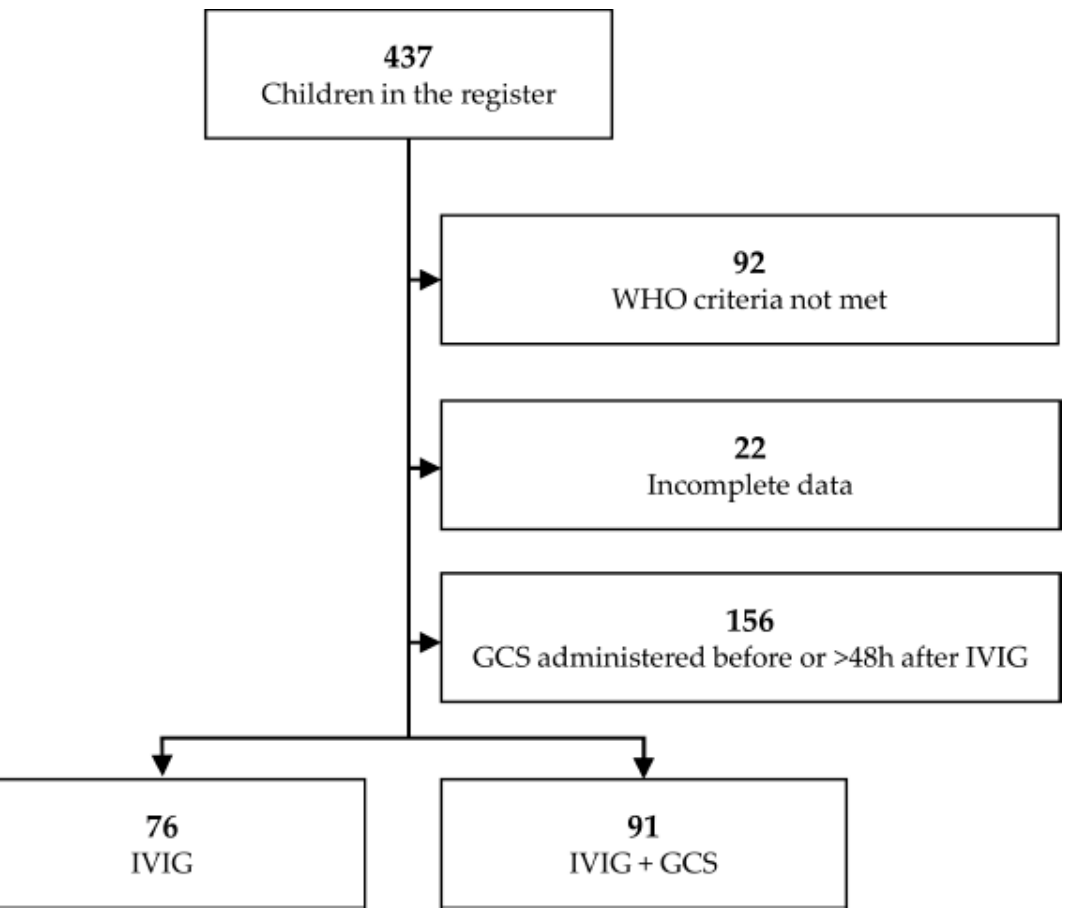
Figure 1. Study flow diagram illustrating the process of selecting patients for inclusion in the study; abbreviations: GCS—glucocorticoids, IVIG—intravenous immunoglobulins.